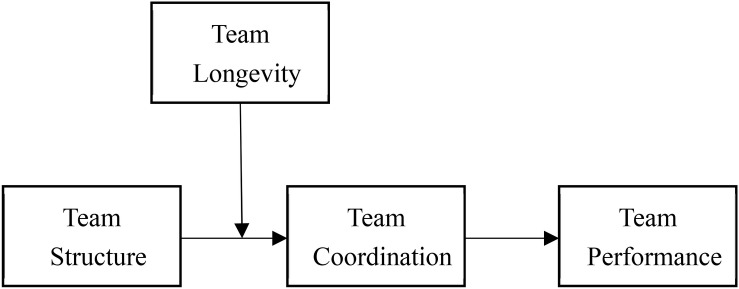
Theoretical model.